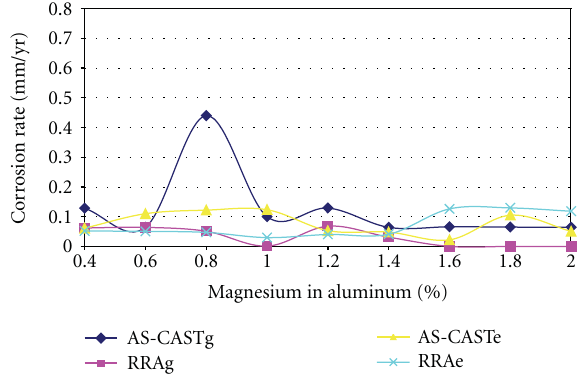
Figure 3: E ff ect of magnesium addition on the corrosion resistance of aluminum alloy in NaCl solution. Note : RRAg and AS-CASTg curves indicate the corrosion responses of heat-treated as-cast Al- Mg alloy specimens, respectively, in saline medium as evaluated through the gravimetric technique while RRAe and AS-CASTe curves illustrate the corrosion behaviors of heat-treated and as- cast Al-Mg alloy specimens, respectively, in saline environment as evaluated through the electrochemical polarization